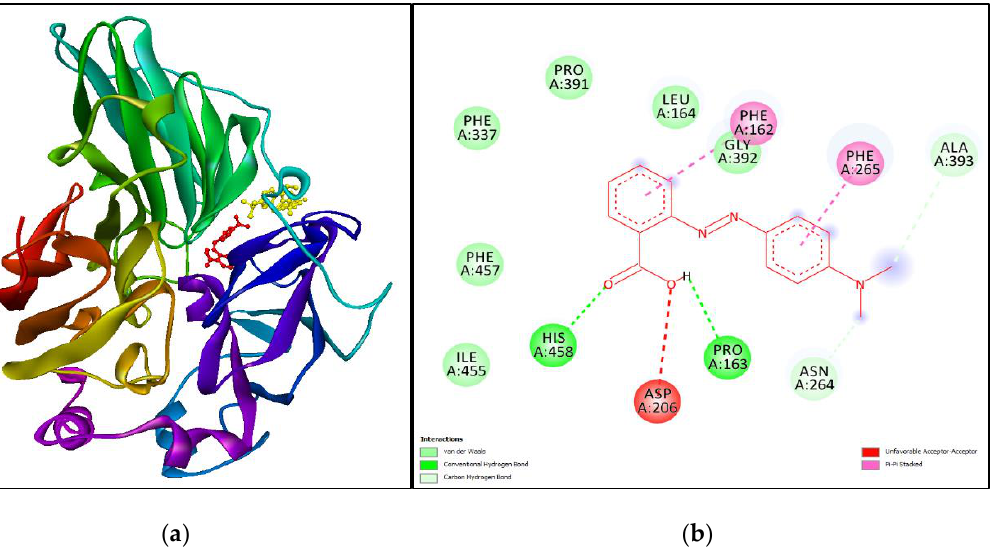
Figure 8. Molecular docking of methyl red with ABTS and laccase; ( a ) methyl red is presented as stick and balls colored in yellow, ABTS as stick and balls colored in red and the enzyme as solid ribbon and ( b ) two-dimensional diagram, the close amino acid residues are presented in green, dashed lines represent intermolecular interactions of different origin (hydrogen bonds — green lines; van der Waals interactions — light green lines; hydrophobic forces — pink lines).